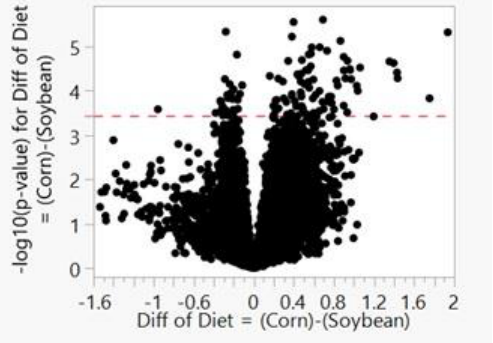
Figure B2. Volcano plot for upper transcripts per kilobase million normalization. The x -axis displays the difference in log scale, and the y -axis plots the –log10( p -value) for each transcript, represented by a point. Significance threshold is graphed with a dotted red line (3.430). Points to the right of 0 and above the significance threshold are significantly increased transcripts, and transcripts that are significantly decreased are to the left of 0 and above the threshold line.